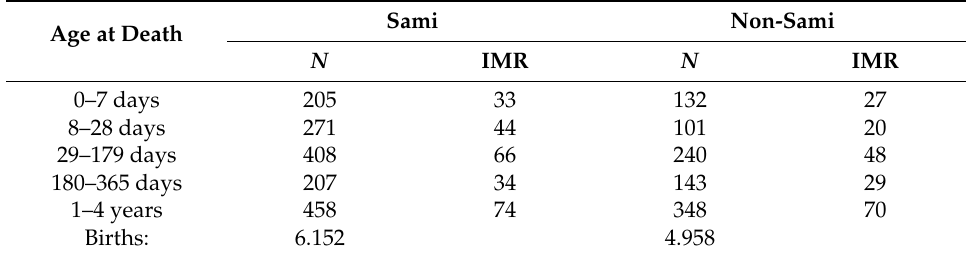
Table 2. Deaths by age groups in North S á pmi, 1800–1899, births and infant mortality rate 1 . Age at Death